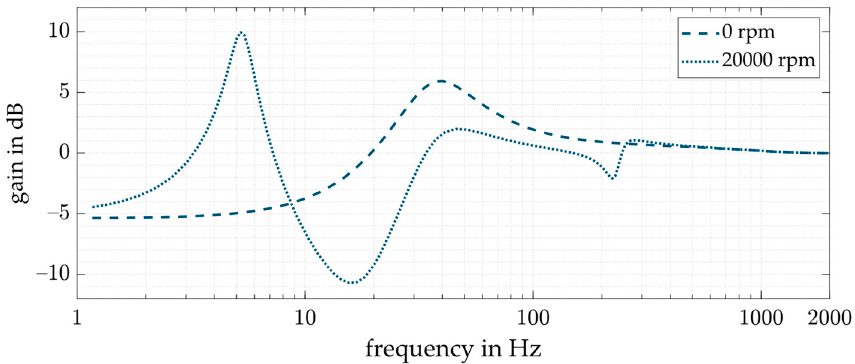
Figure 6. Sensitivity function for the system with a decentralized PD control for standstill and 20,000